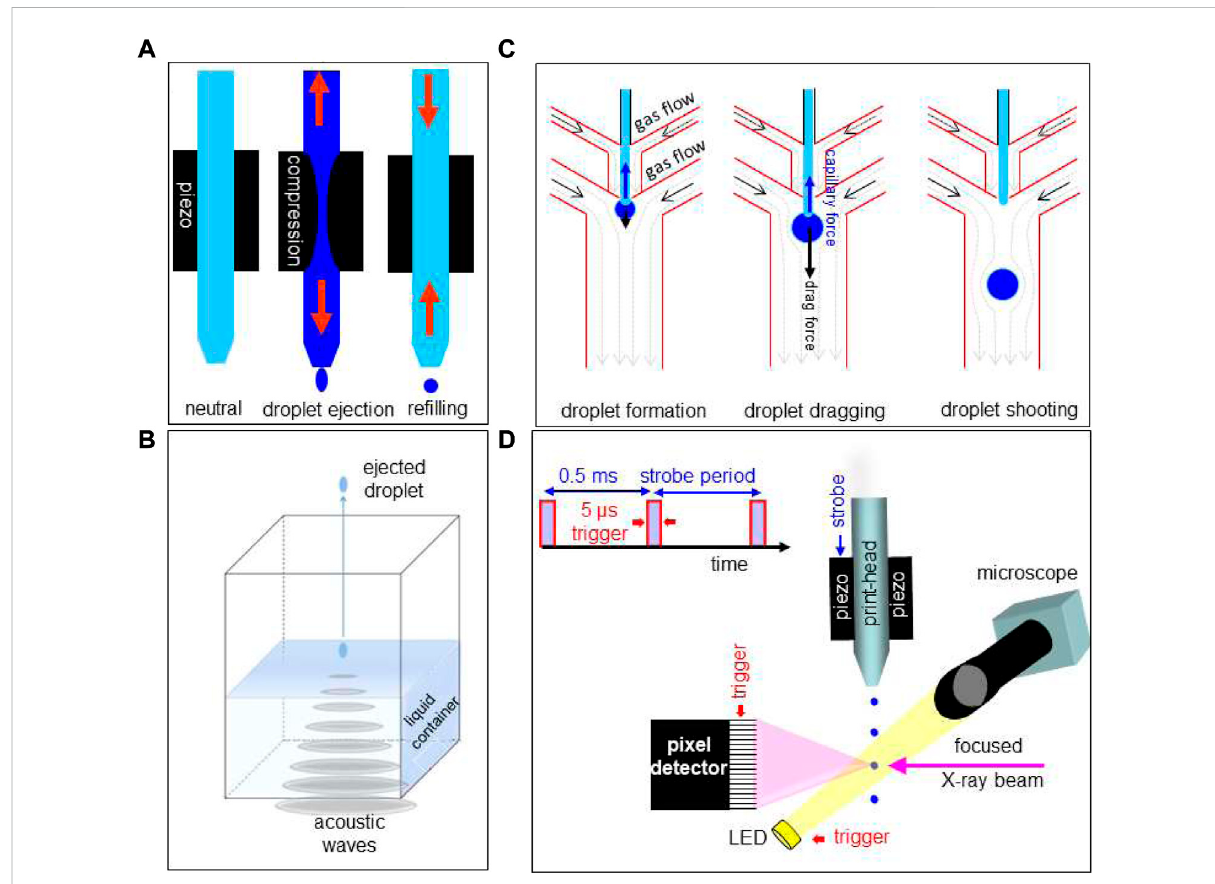
FIGURE 4 (A) Schematic operation sequence of DOD inkjet system. Adapted from: (Graceffa 2010). (B) Schematic design of acoustic droplet ejection (ADE) system. Adapted from: (Teplitsky et al., 2015). (C) Operating sequence for hybrid gas/liquid droplet generating system. Adapted from: (Kazoe et al., 2021). (D) Schematic design of DOD inkjet system integrated into a SR beamline. Strobe period and trigger of detector framing time are generated by electronic modules, integrated into the beamline control system. Droplets are ejected at 2 KHz by strobe-pulses acting on the piezo. During the fl ight of a ballistic droplet through the focused SR beam, the pixel detector frontend and the LED are activated by trigger-pulses. Adapted from: (Graceffa